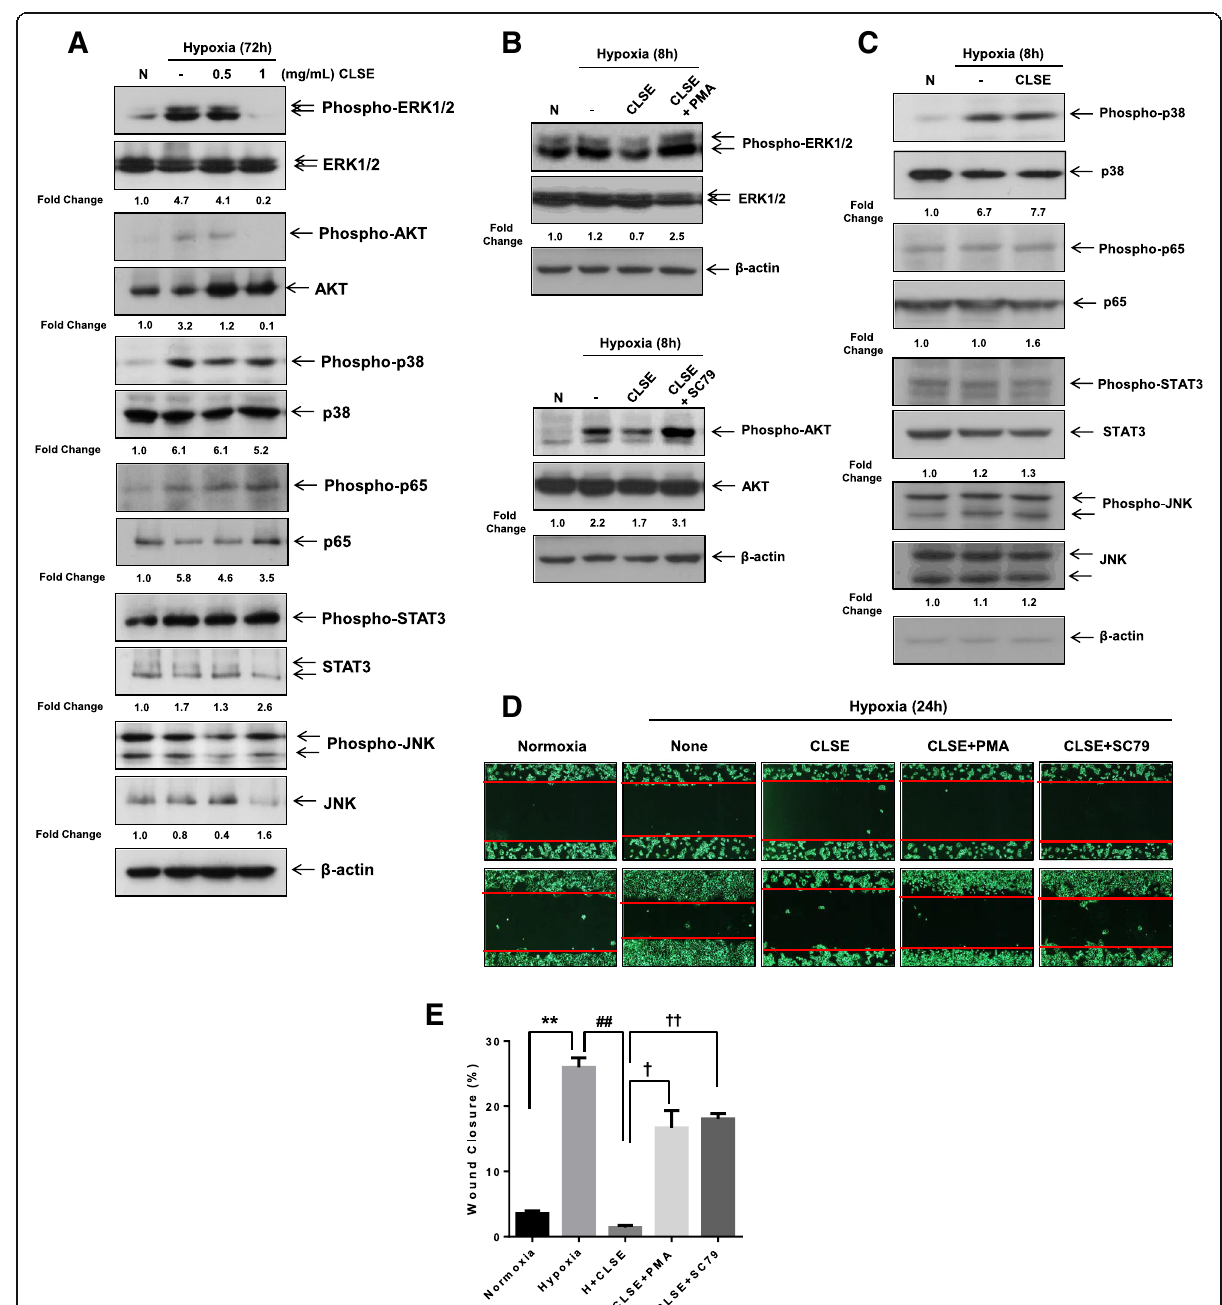
Fig. 4 Effect of CLSE on signaling pathways under hypoxic conditions. a . CLSE-treated HCT116 cells under hypoxic conditions for 72 h were analyzed by western blot analysis. ERK1/2 and AKT phosphorylation were downregulated by CLSE treatment under hypoxic conditions. b , c . After cells were treated with CLSE (1 mg/mL), PMA (5 ng/mL) or SC79 (5 μ g/mL) for 8 h under hypoxic conditions, signaling proteins were examined through western blot analysis. d . Representative scratch-wound images showing the effect of PMA and SC79 on the healing ability of HCT116 cells (magnification: 40×). After cells were treated with CLSE (1 mg/mL), PMA (10 ng/mL), or SC79 (2.5 μ g/mL) for 24 h under hypoxic conditions, migrating cells were analyzed using ImageJ software. e . Percentage of HCT116 cells that migrated to the wound area following combined treatment with CLSE and PMA or SC79. ** p < 0.001 versus normoxia control group. ## p < 0.01 versus hypoxia-only group. † p < 0.05, †† p < 0.01 versus hypoxia and CLSE treated group. Data are mean ± SD ( n = 3). N, Normoxia; H, hypoxia; CLSE, Coix lacryma-jobi var. ma-yuen Stapf sprout extract; ERK, extracellular signal-regulated kinase; AKT, protein kinase B; PMA, phorbol 12-myristate 13-acetate; SD, standard